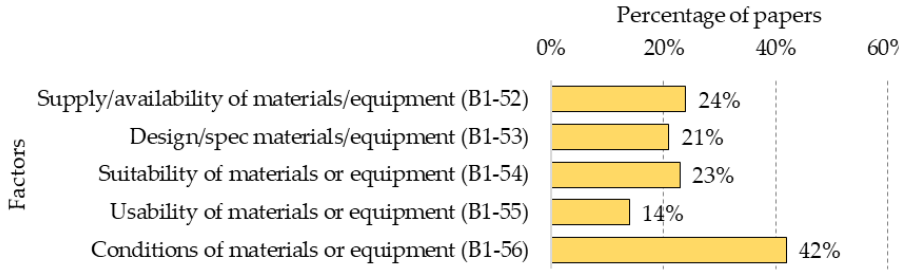
Figure 8. Percentage distribution of factors in the “Materials and equipment (B)” category.